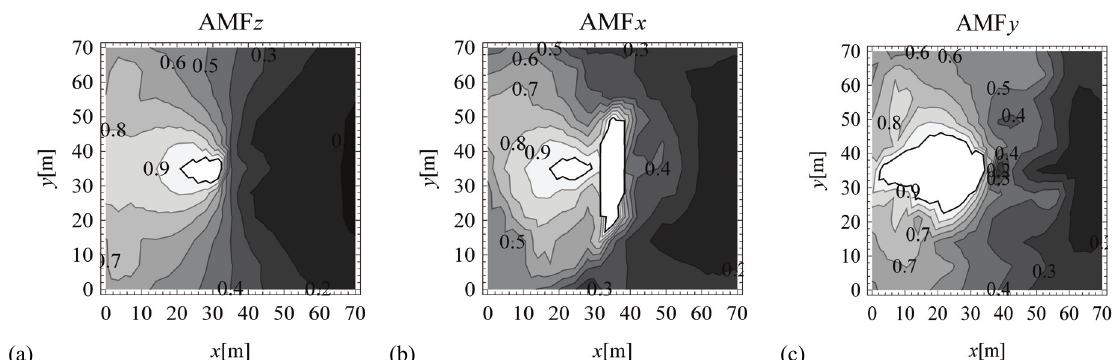
Fig. 6. AMF for the analyzed domain with the three displacement components for the points located 5 m. below the ground surface, r = 2 m; plot range: 0 < AMF < 1; (a) displacement component in the z -direction, (b) displacement component in the x -direction, (c) displacement component in the y